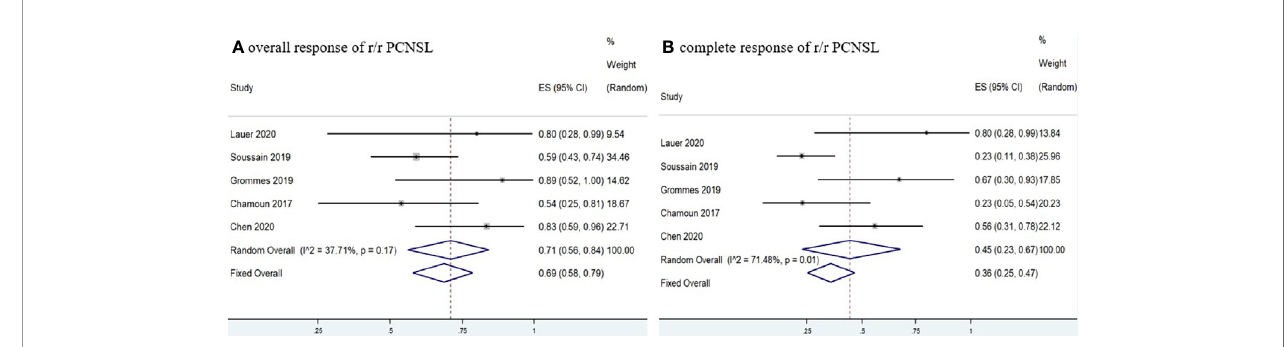
FIGURE 7 | Pooled response rates of refractory/relapsed primary central nervous system lymphoma (r/r PCNSL). (A) Pooled overall response of r/r PCNSL. (B) Pooled complete response of